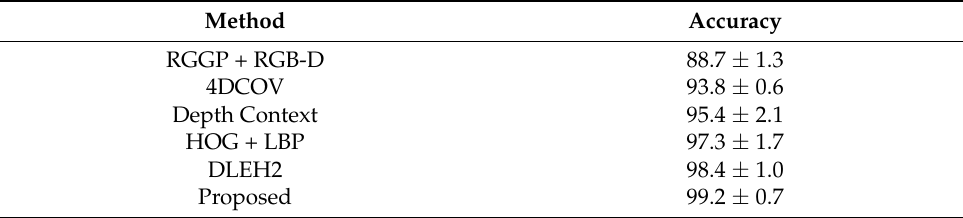
Table 1. The recognition accuracy on SKIG